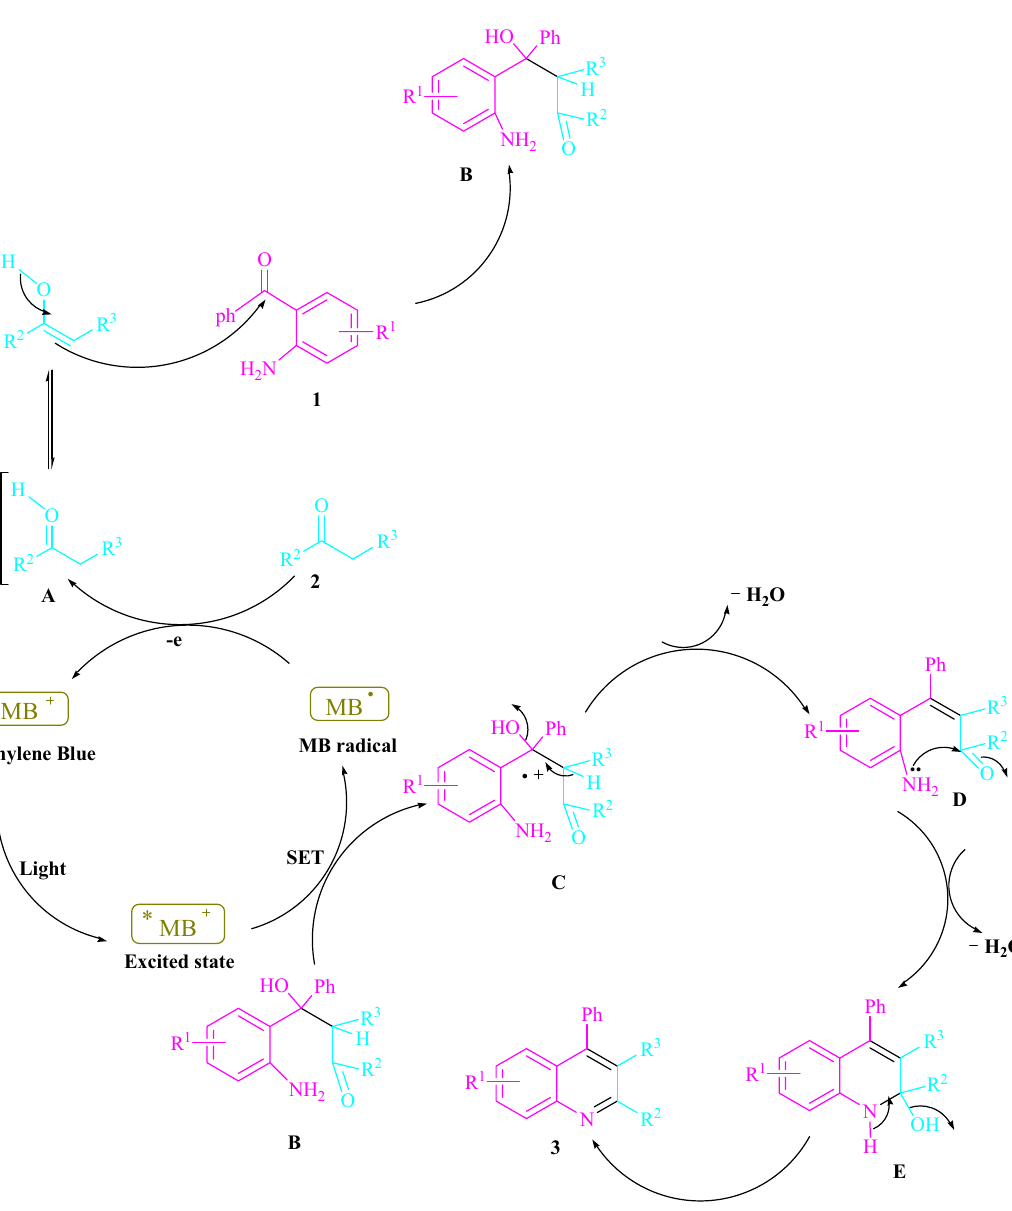
Figure 4. A mechanistic method for producing polysubstitutedquinolines has been